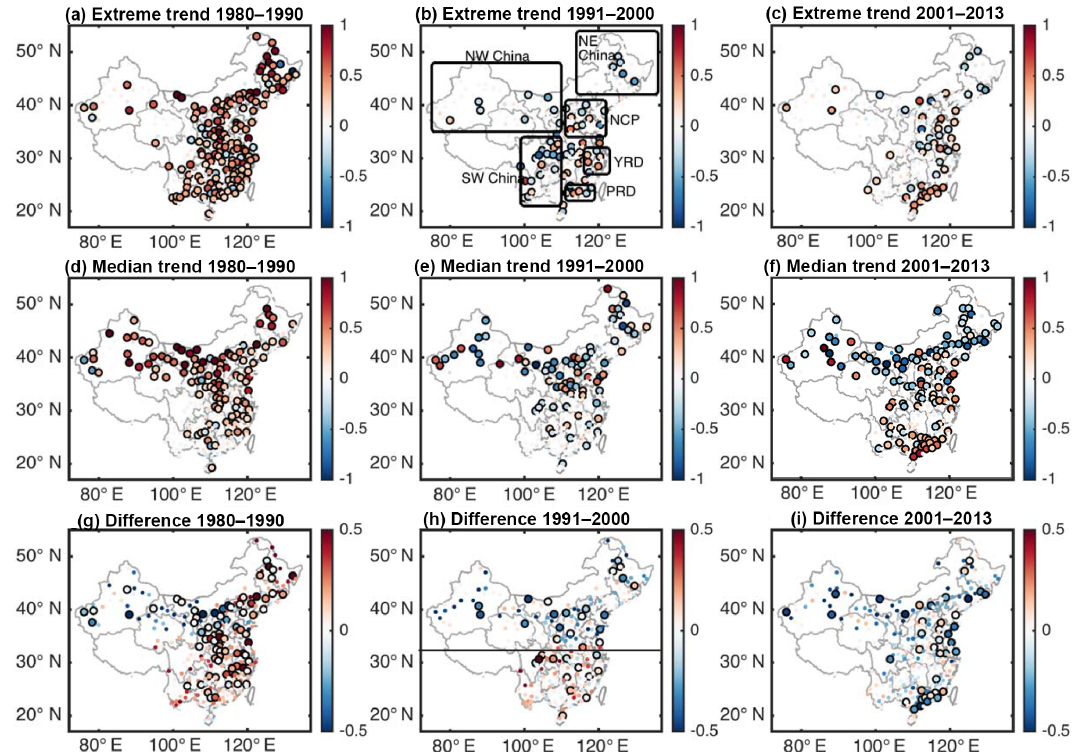
Figure 1. The first row: extreme trends estimated using quantile regression for the 3 decades: 1980–1990 (a) , 1991–2000 (b) , 2001–2013 (c) . Panels (d–f) : median trends estimated using quantile regression for the 3 decades. Panels (g–i) : the difference between the values of the extreme trends and median trends, calculated as the extreme minus the median. All trends are unitless and expressed as relative